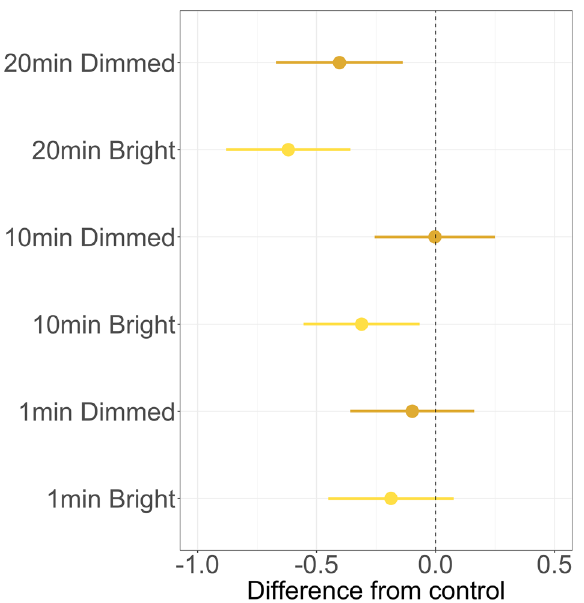
Figure 5. Results of post-hoc tests in the interval experiment. The graph shows the estimated coefficients and 95% confidence intervals of six experimental pairs when comparing the difference in ‘light-on’ vs ‘light-off’ to the control (‘light-off’ vs ‘light-off’, dashed line). It showed that both 20-min treatments, as well as the 10-min bright treatment, had a significant effect on the number of birds, whereas the 10-min dimmed treatment and both 1-min treatments did not. For detailed statistics, see Table